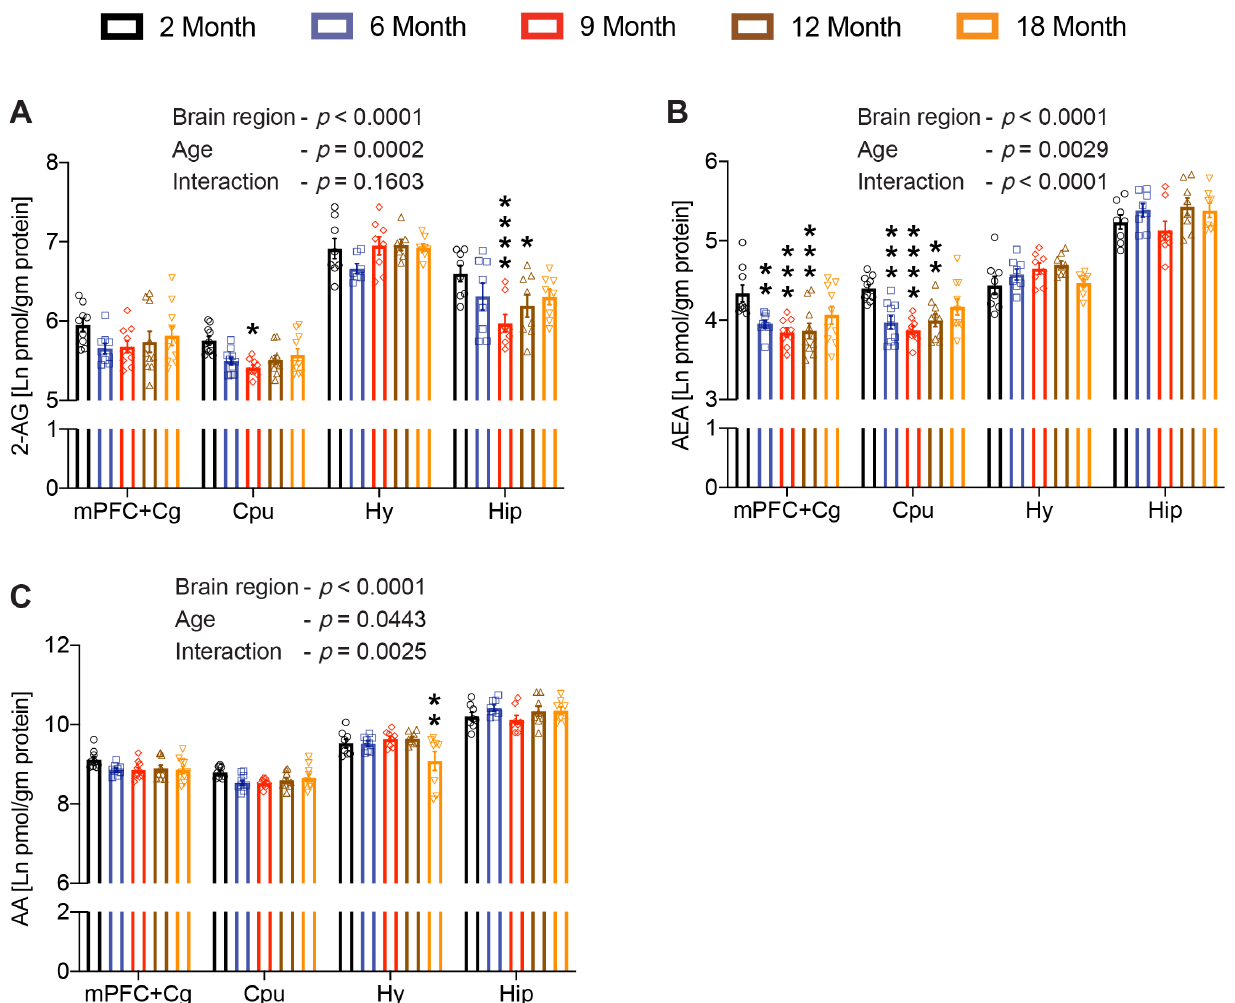
Figure 1. Age-related changes in the endocannabinoids. Brain 2-AG ( A ), AEA ( B ) and AA ( C ) levels were analyzed in medial prefrontal cortex including the cingulate cortex (mPFC+Cg), striatum (CPu), hypothalamus (Hy), and hippocampus (Hip) of 2-, 6-, 9-, 12- and 18-month-old mice. Both 2-AG and AEA levels were significantly altered in a brain region-specific manner across the age groups, whereas AA levels were only altered specifically in the hypothalamus of aged mice ( n = 7–10 mice per age group). Data are represented as mean ± SEM, * p < 0.05; ** p < 0.01; *** p < 0.001; **** p < 0.0001; linear mixed model analysis followed by Dunnett’s multiple comparison test. p -values refer to pairwise tests against the 2-month-old group.